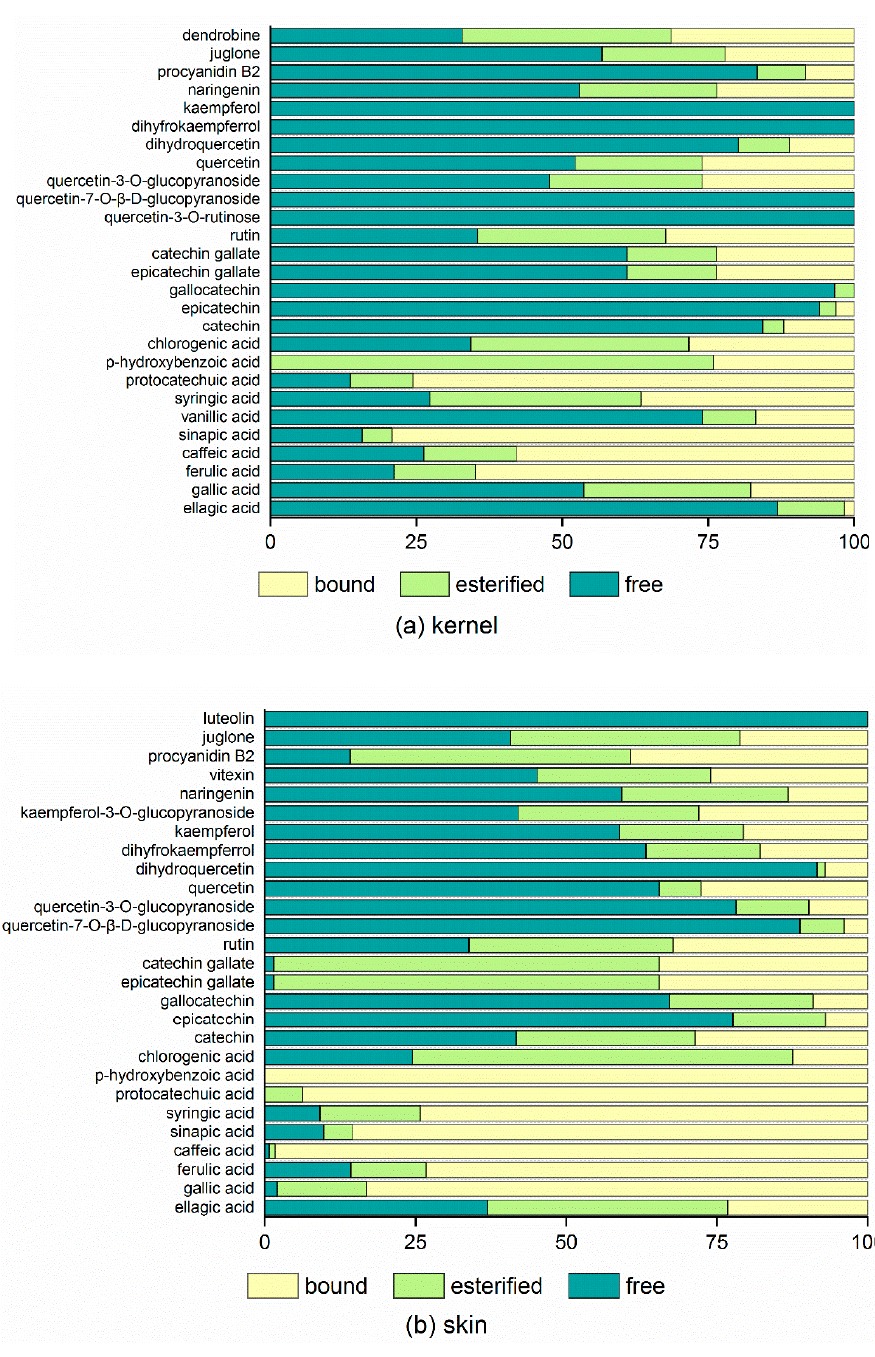
Figure 1. A comparison of phenolic compounds in ( a ) kernel and ( b ) skin of walnut. Note: the horizontal axis indicates percentages of three phenolic forms (free, esterified, and bound); the vertical axis indicates phenolic components.